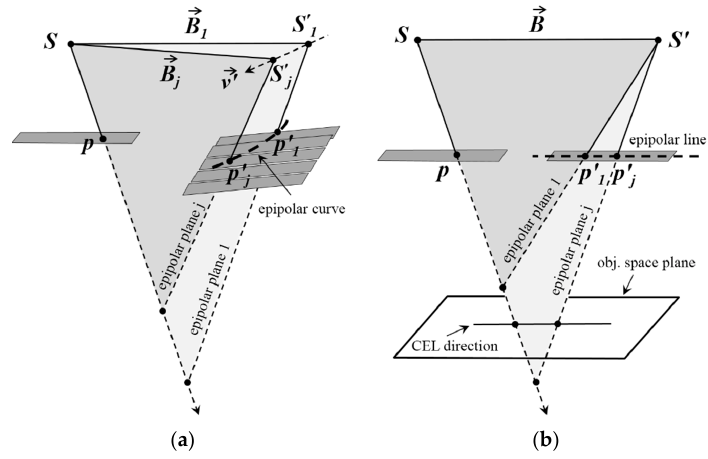
Figure 2. The EG of cross-track linear pushbroom imagery: ( a ) General case; ( b ) Ideal case.